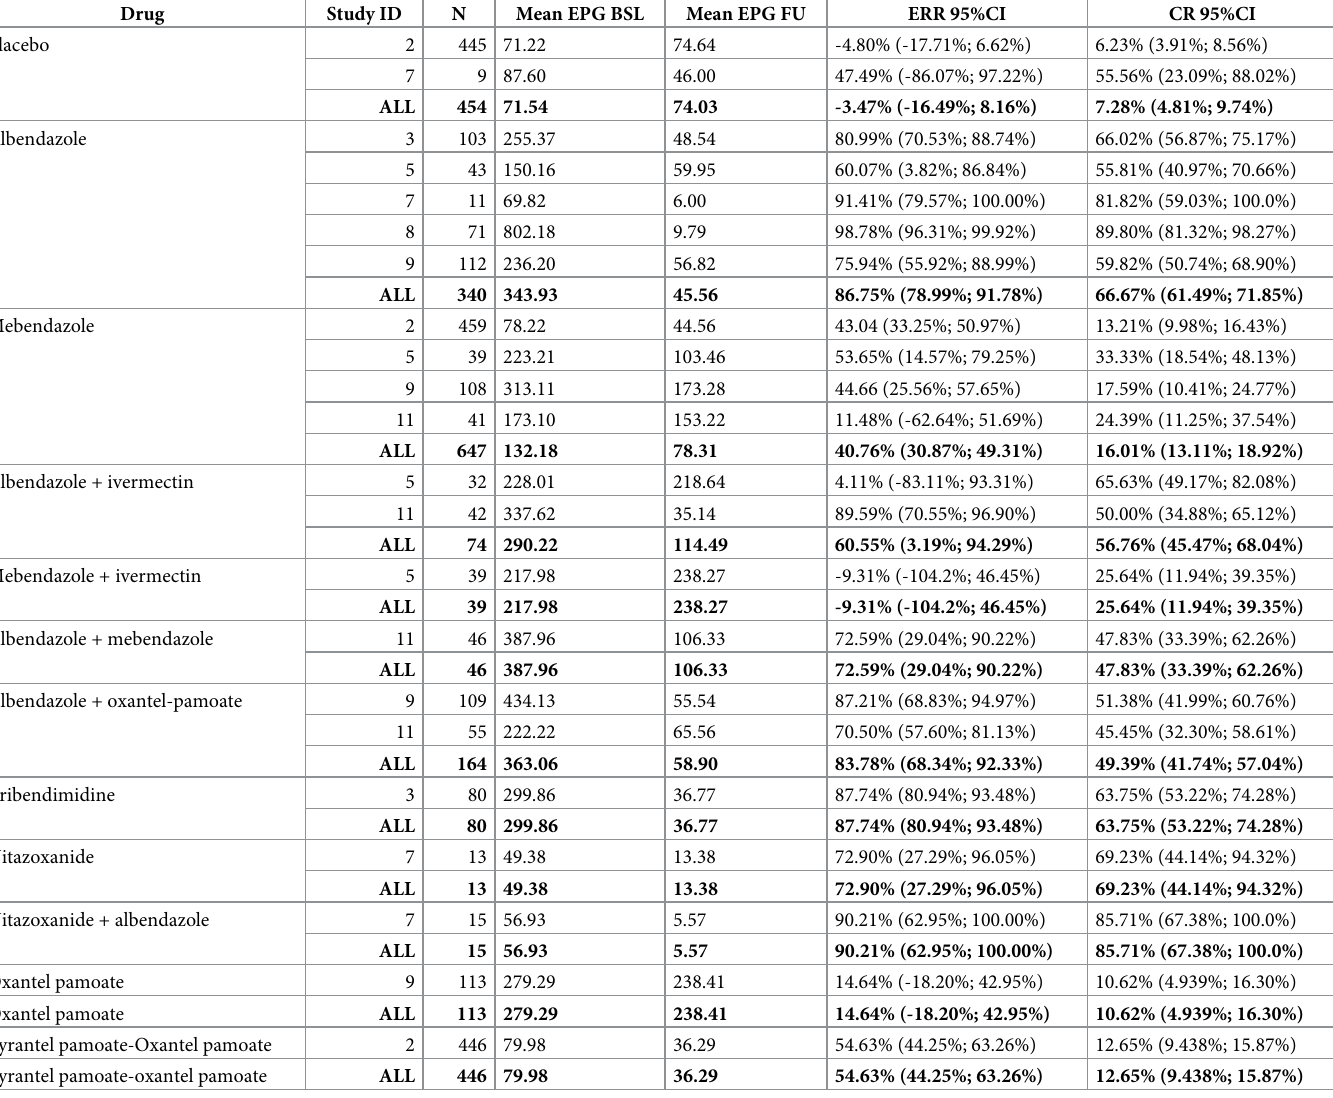
Table 6. Egg count arithmetic means before and after treatment and drug efficacy outcomes (group egg reduction rate, ERR) for studies with follow-up duration between 14 and 21 days for hookworm.